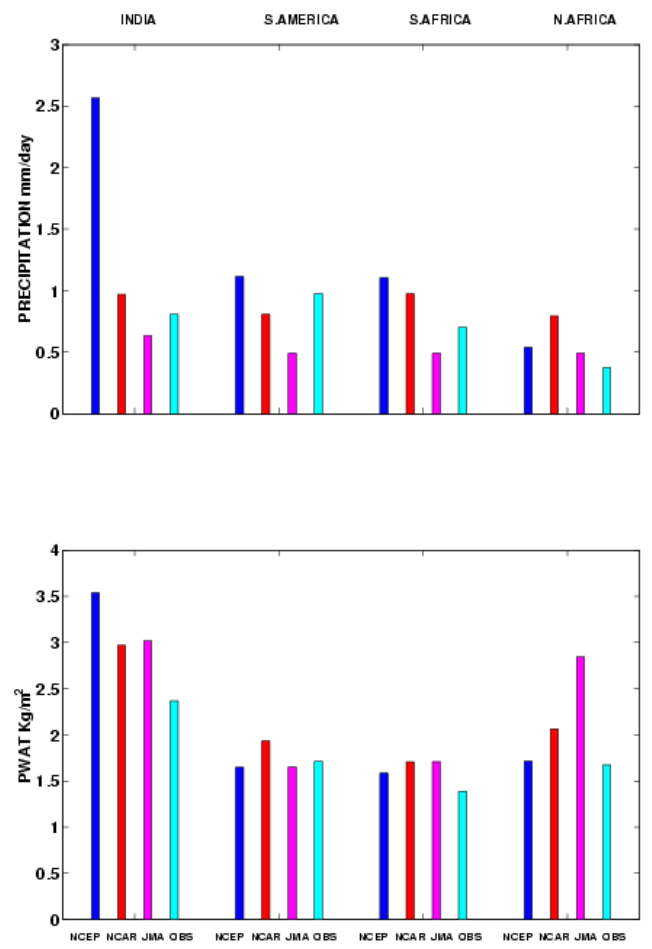
Fig. 7. Interannual standard deviation of monthly mean rainfall and integrated water vapour in NCEP, NCAR and JMA GCM.